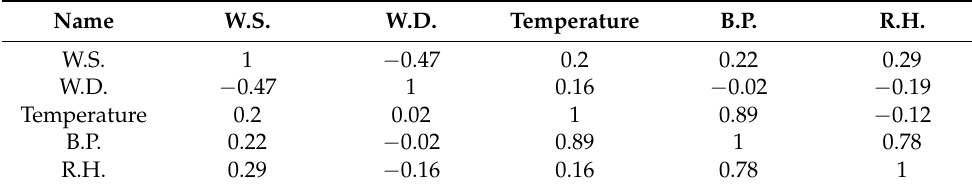
Table 5. Correlation matrix for wind speed